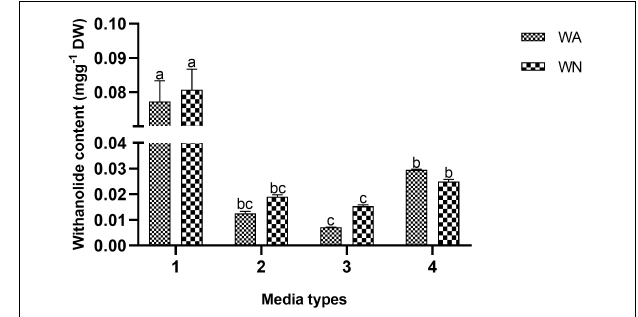
FIGURE 6 | Expression of selected withanolide biosynthetic pathway genes analyzed by qRT-PCR in the leaves of Withania somnifera from vegetative (VP) and reproductive (RP) growth phases. The data were represented as mean ± SEM of fold change with respect to VP phase ( n = 3) and multiple